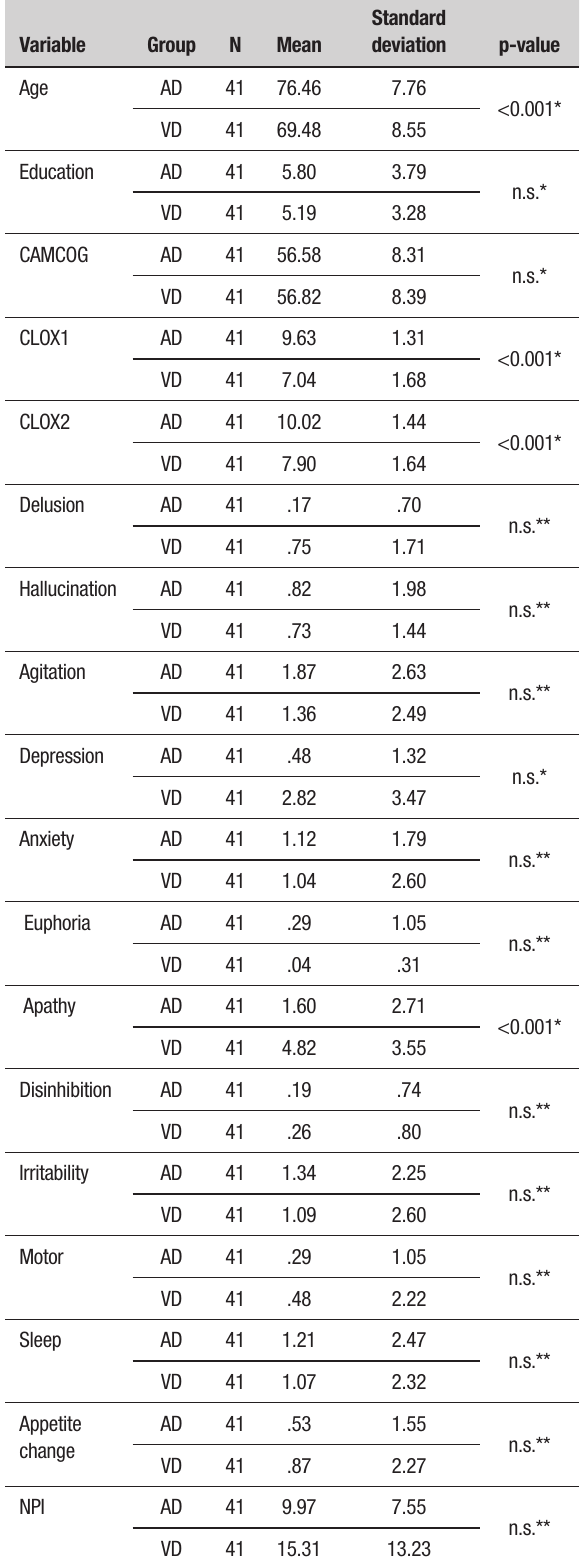
Table 1. Differences between diagnostic groups for continuous sociodemo- graphic, cognitive and behavioral variables.